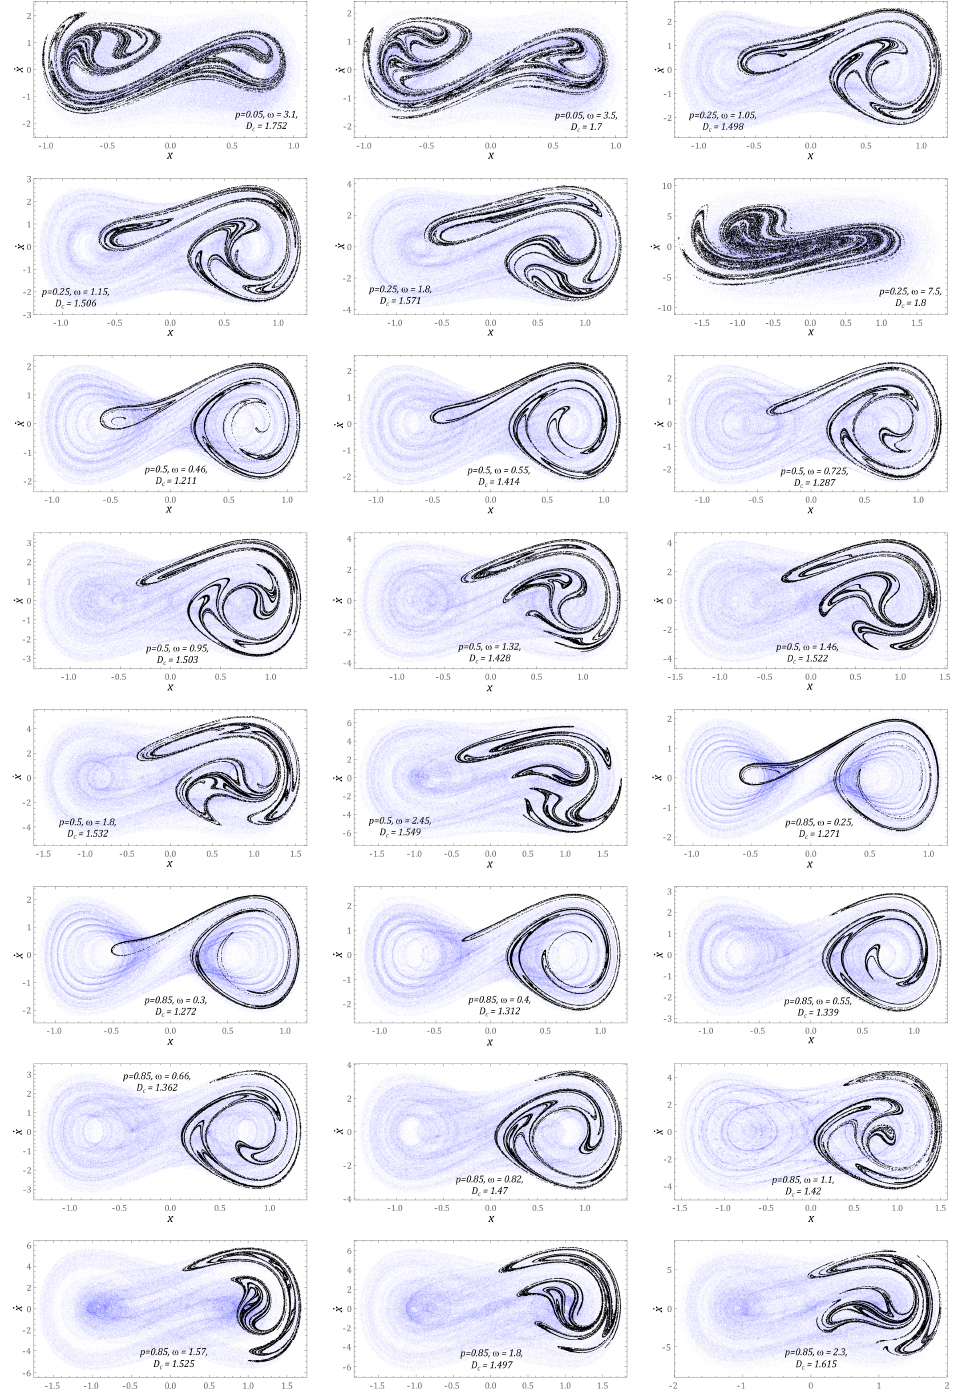
Figure 7. Exemplary solutions showing the geometrical structures of chaotic phase flows and the corresponding Poincare cross-sections of a BEH. D C denotes the corresponding correlation dimension. . x are ω , p , x , and